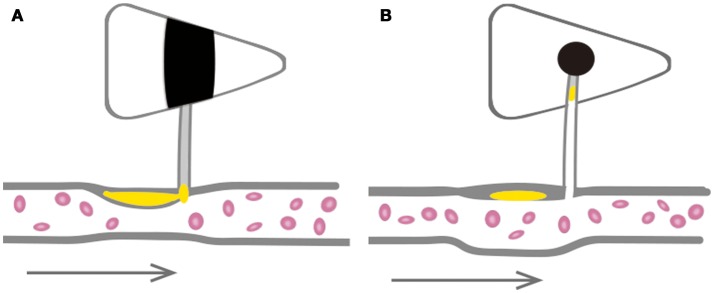
Schematic diagrams of large arteries involved in the pathogenesis of BAD and LI in anterior circulation. (A) BAD is probably associated with the occlusion of perforating artery with a relatively large and stable atherosclerosis plaque in great artery. (B) LI may be associated with the occlusion of distal branches of perforating artery by dropped embolus from relatively small and unstable atherosclerosis plaque in great artery.